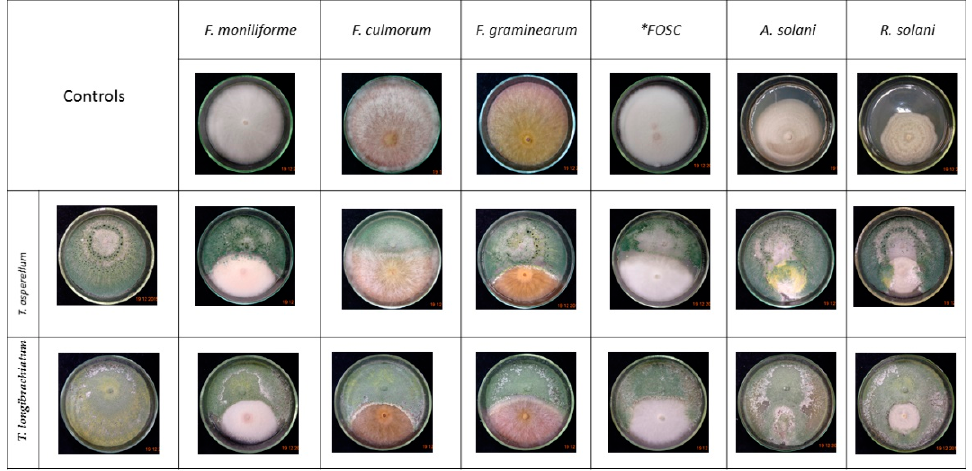
Figure 3. In vitro confrontation experiments between Trichoderma asperellum IRAN 3062C, Trichoderma longibrachiatum IRAN 3067C and plant pathogenic fungi on MEA after 7 days. * FOSC: Fusarium oxysporum species complex.